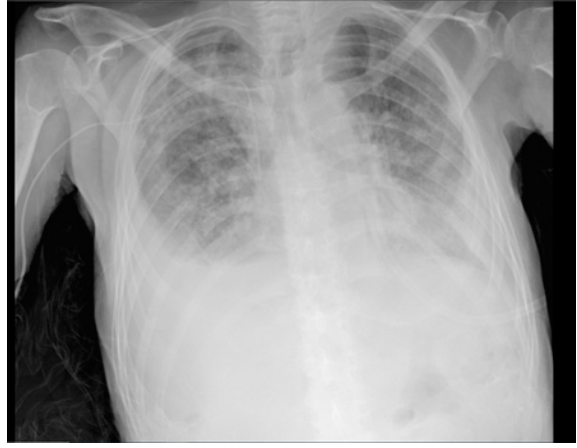
Figure 6. April 2022. Diffuse pulmonary interstitial disease and lung progression during non-invasive ventilation.